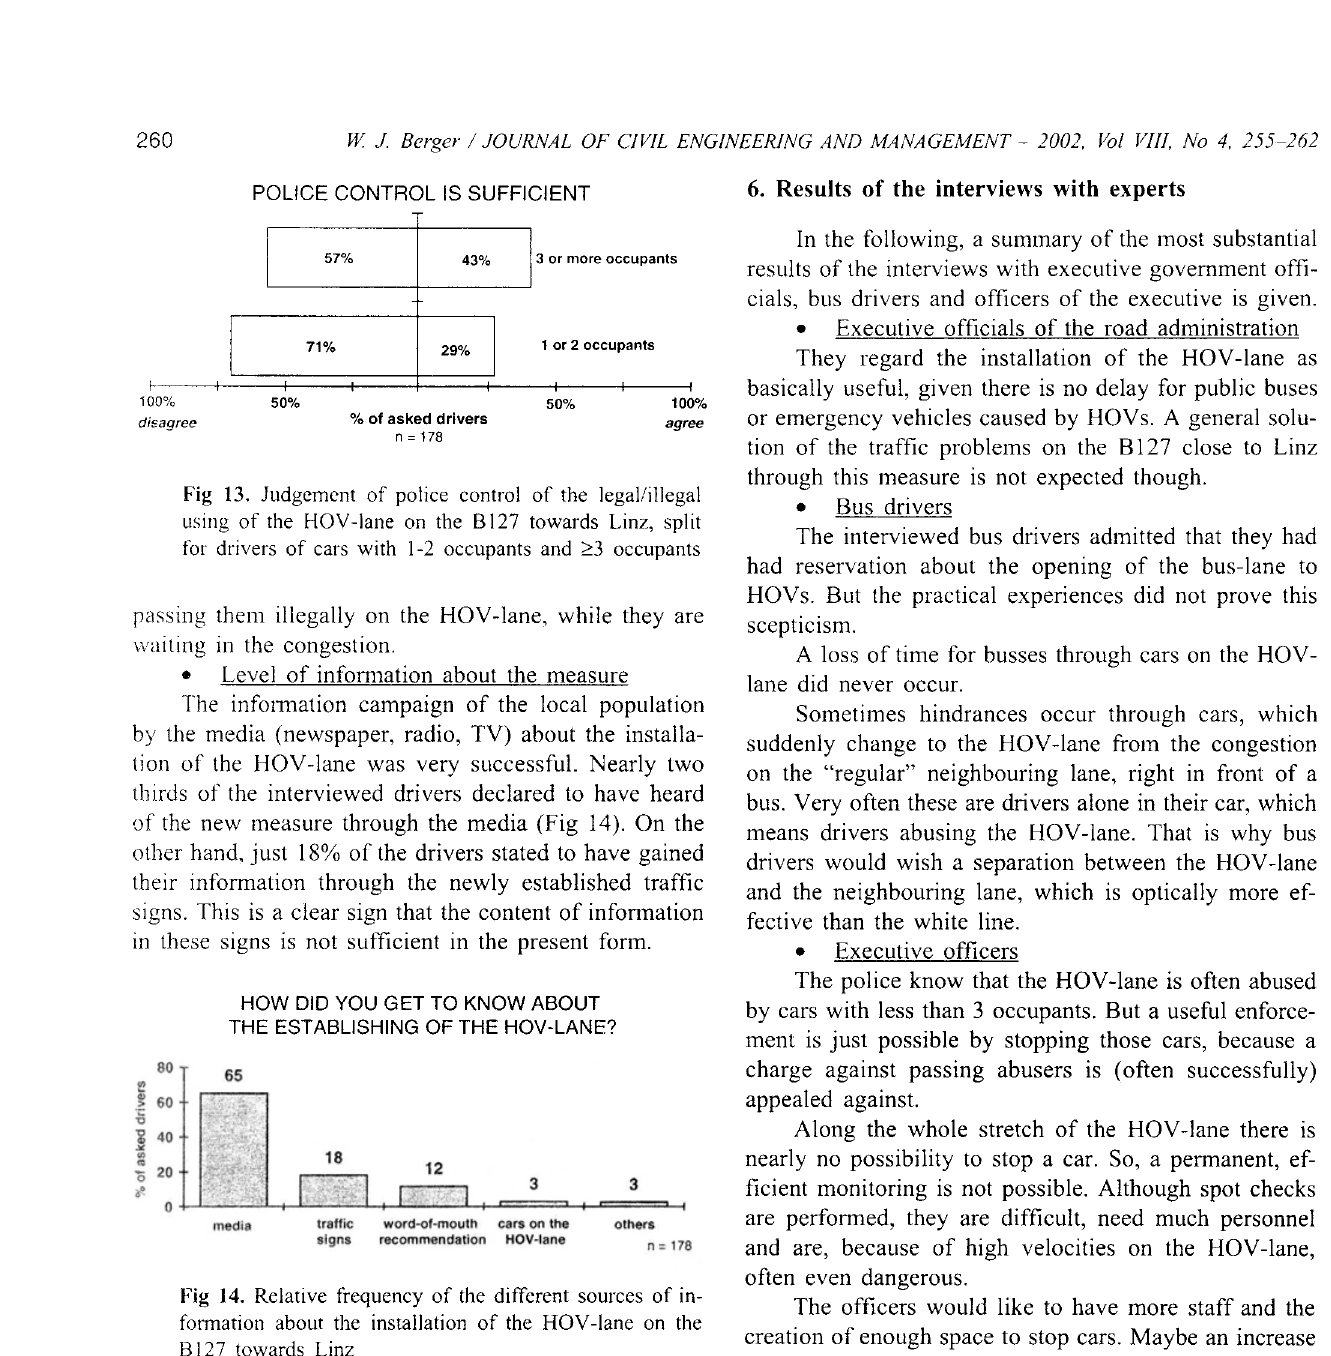
Fig 14. Relative frequency of the different sources of in fotmation about the installation of the HOY-lane on the 8 127 towards